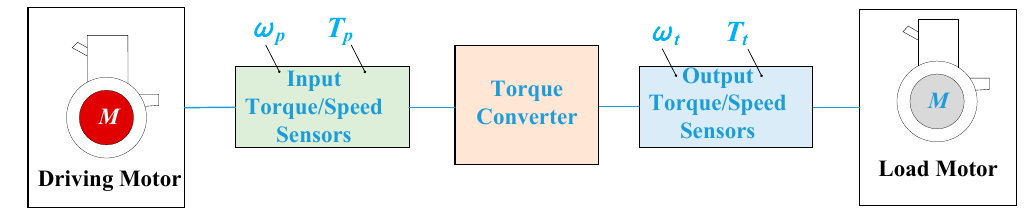
Figure 12. Principle diagram of the test stand in Pohl’s study [8].